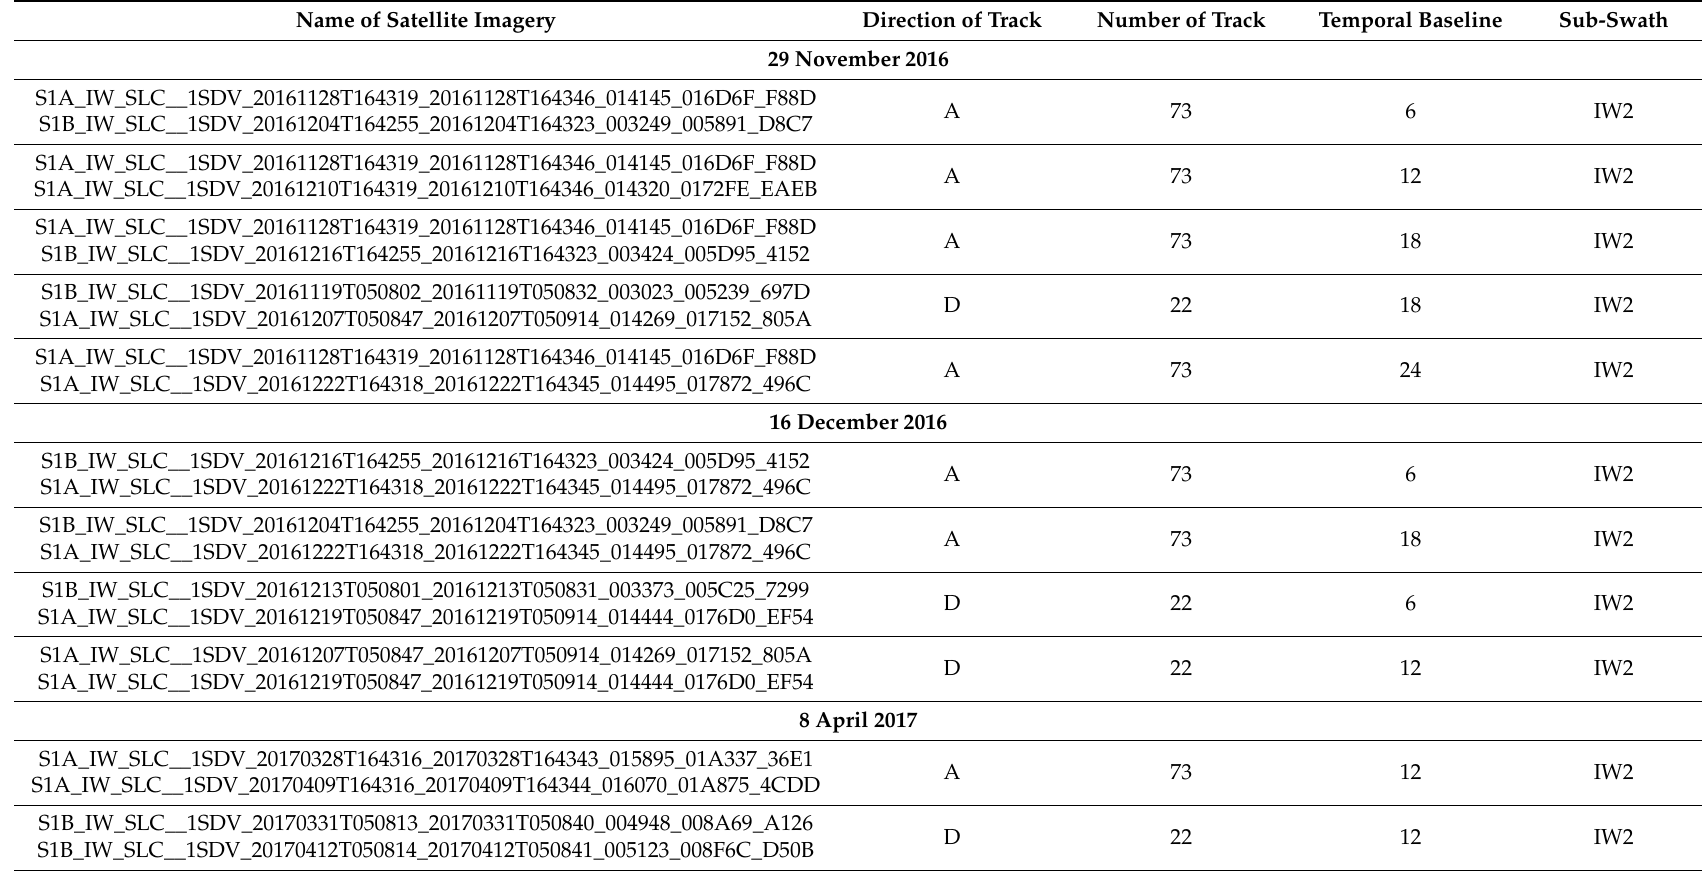
Table A1. Satellite imagery on the basis of which 37 correct interferograms were